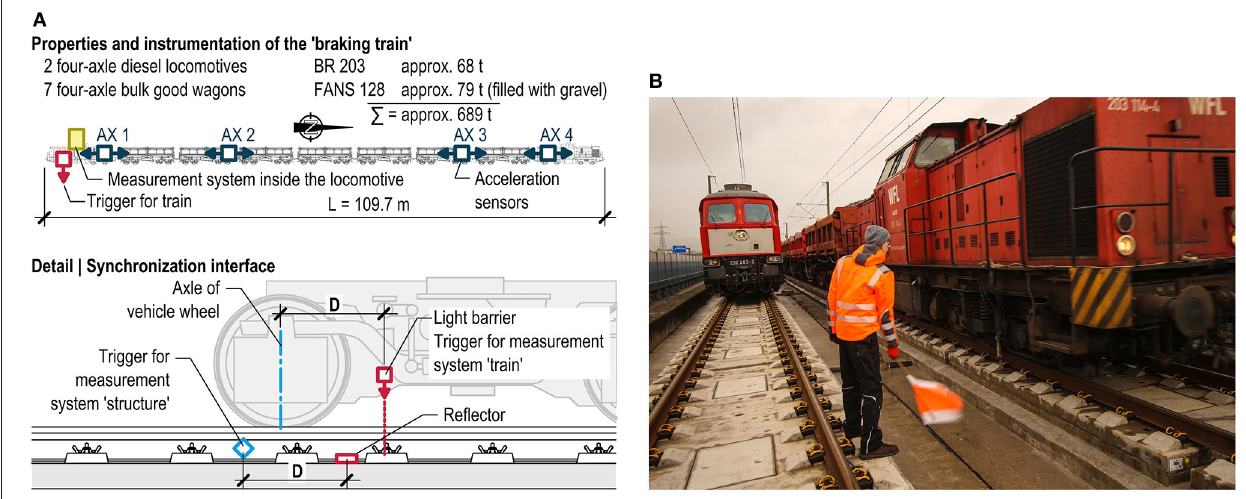
FIGURE 11 | (A) Arrangement of the measurement devices on the train and synchronization of the measurement systems on the train and the bridge. (B) Braking train on the first track, stationary train on the other track located in the area of the bridge joint. Reproduced from Wenner et al. (2019) with permission from [Marc Wenner].